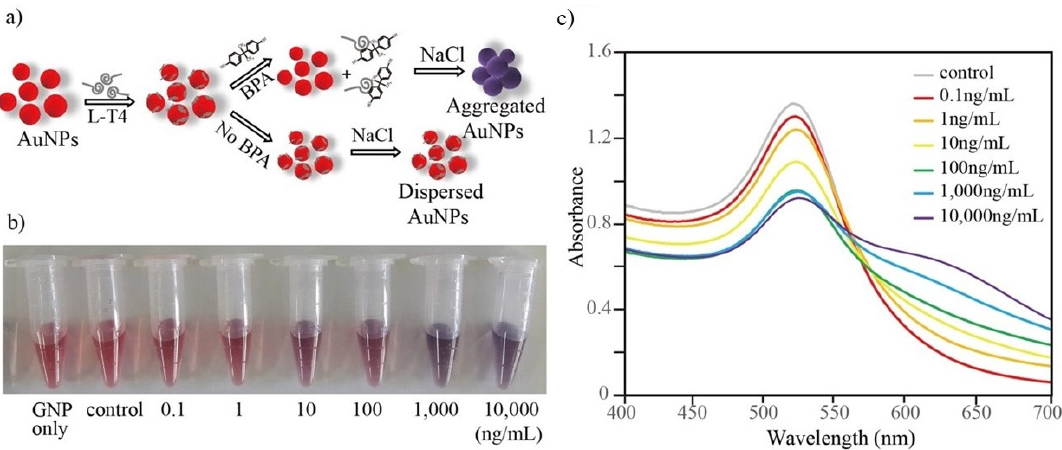
Figure 6. ( a ) A schematic diagram of AuNP-spiegelmer-based BPA detection. ( b ) An image of the color change for the L-T4-AuNP assay. ( c ) UV–vis absorbance spectra of the L-T4-AuNP assay with various concentrations of BPA.